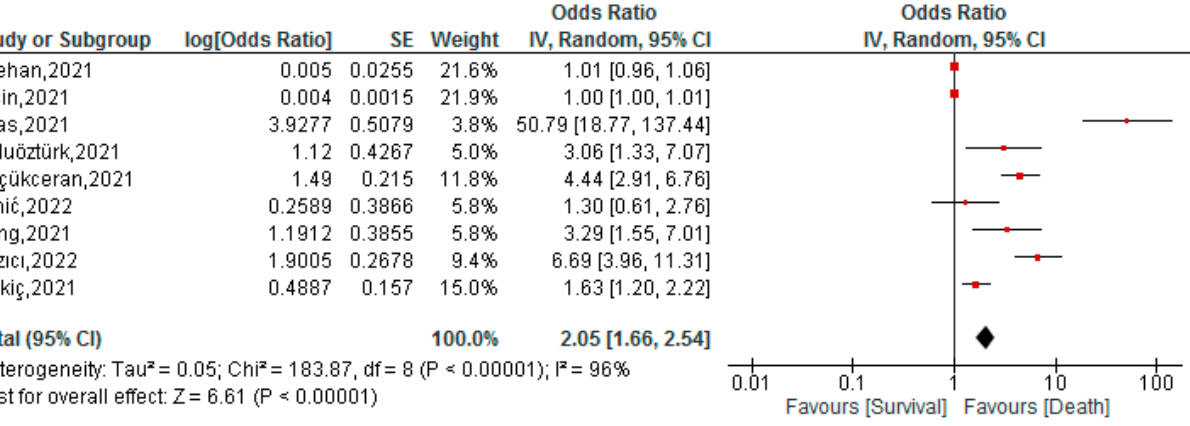
Figure 3. Association between FAR and mortality of COVID-19 patients [34,35,37,38,40–43,52].